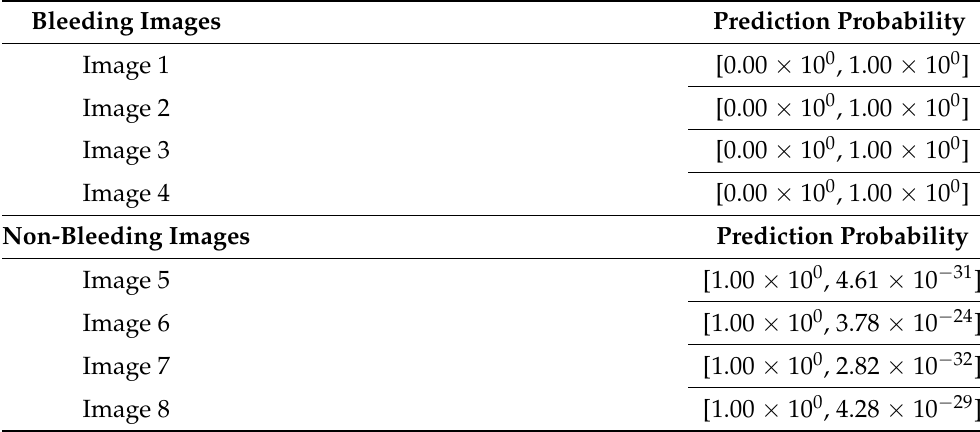
Table 3. Prediction probabilities for non-bleeding and bleeding classes for a few of the sample validation images.